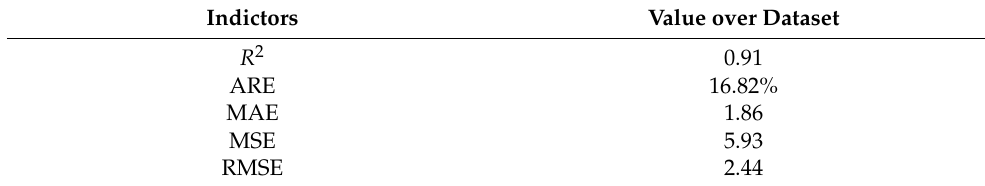
Table 6. Statistical indictors of simplified symbolic